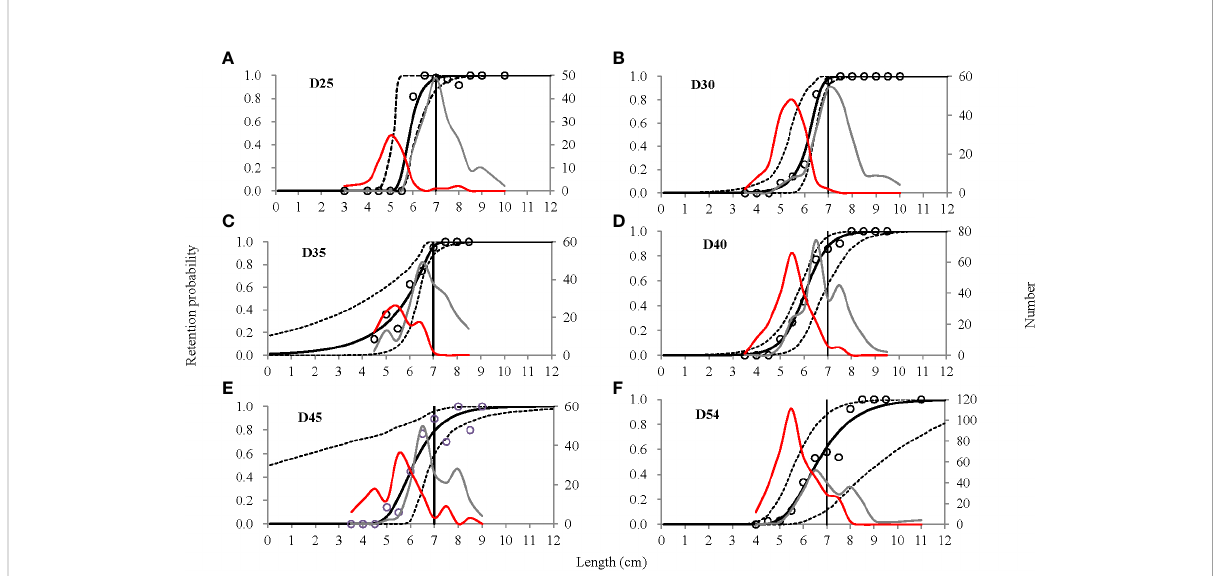
FIGURE 4 The experimental catch proportion and selectivity curves are obtained for the tested codends. The circular marks represent the experimental catch proportion. The red curves represent the size distribution of shrimp caught by the cover, and the gray curves represent the one caught by the tested codend. The solid black curves represent the selectivity curves, and the stippled curves describe the 95% con fi dence intervals. The vertical lines represent the minimum conservation reference size (7.0 cm) of the target shrimp. (A – F) represents the D25, D30, D35, D40, D45 and D54 codend,